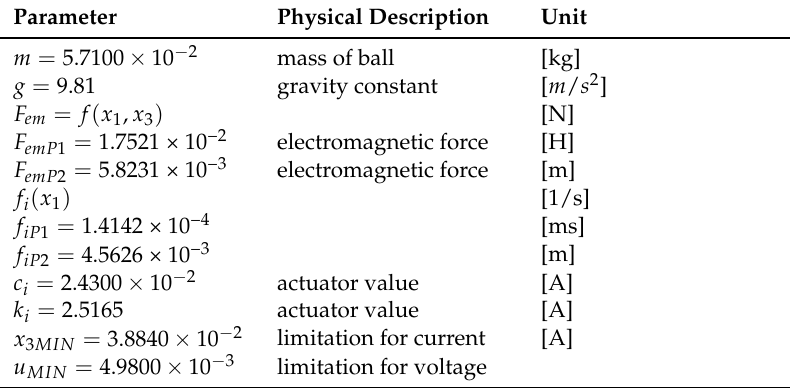
Table 1. Physical parameters of the ML